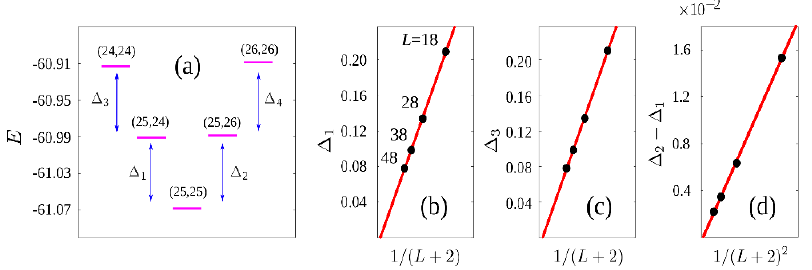
Figure 5 . (a) Energy spectrum of the SU(2) model with L = 48. Quantum numbers for each column are given as ( N f 1 ; N f 2 ) in the panel. (b){(e) Finite-size scaling of (cid:1) 1 ; 3 and (cid:1) 1 (cid:0) (cid:1) 2 in the energy spectrum. 1 = ( L + 2) scaling is also observed in (cid:1) 2 ; 4 and 1 = ( L + 2) 2 scaling is also